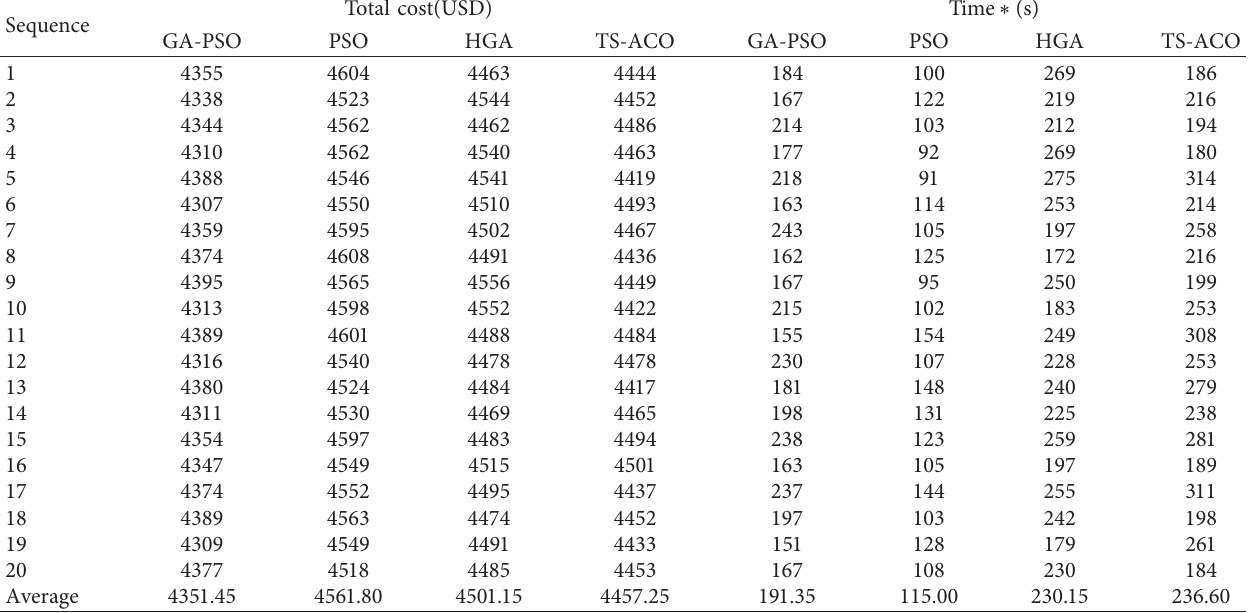
Table 8: Comparison of algorithms’